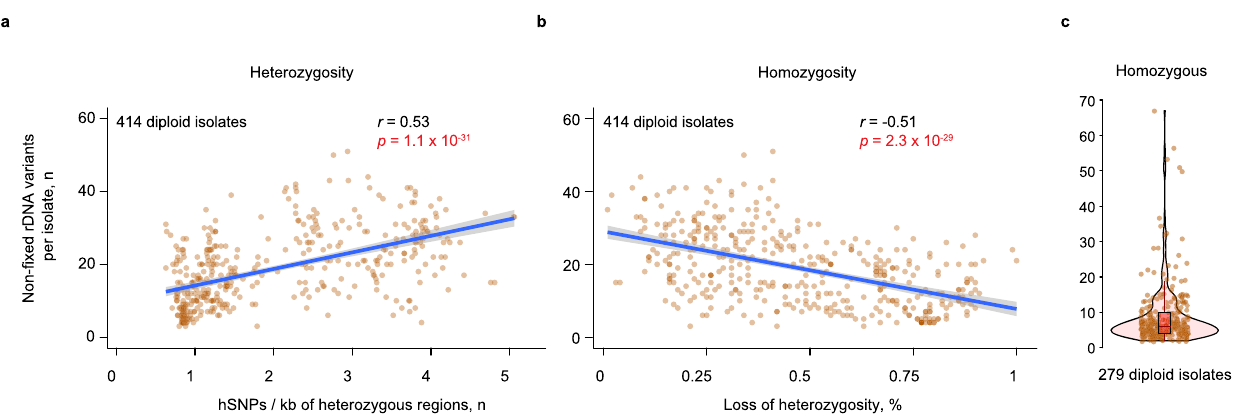
Fig.3|RelationshipbetweensequencediversityoftherDNAandtherestofthe genomeindiploidisolates. CorrelationbetweenthenumberofrDNAvariantsand a the number of heterozygous SNPs per heterozygous region of the genome (excluding rDNA) 32 or b the loss of heterozygosity per heterozygous isolate. Pear- son correlation coef fi cient R is shown. Each dot represents an isolate. The regres- sionline(blue)isplottedwithlinearregressionmodel.Thegrayshadingisa95%CI. Signi fi cance test: two-sided Pearson ’ s product-moment correlation. For a , t(412) =